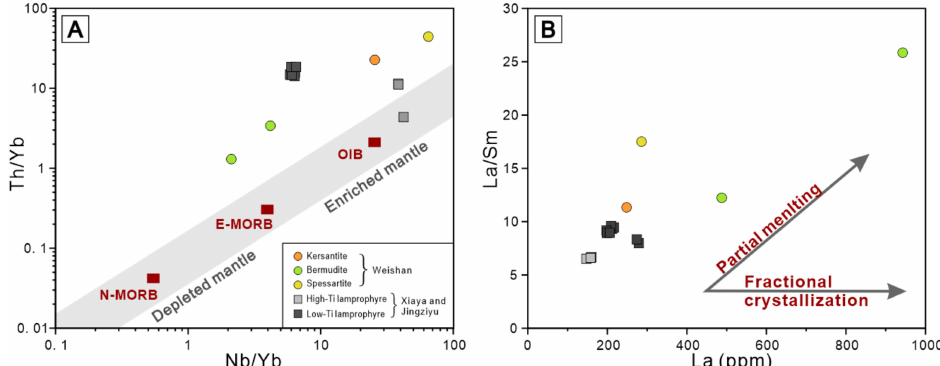
Figure 11. ( A ) Th/Yb vs. Nb/Yb diagram of the lamprophyre from the Weishan area [58]. ( B ) La/Sm vs. La diagram [59].